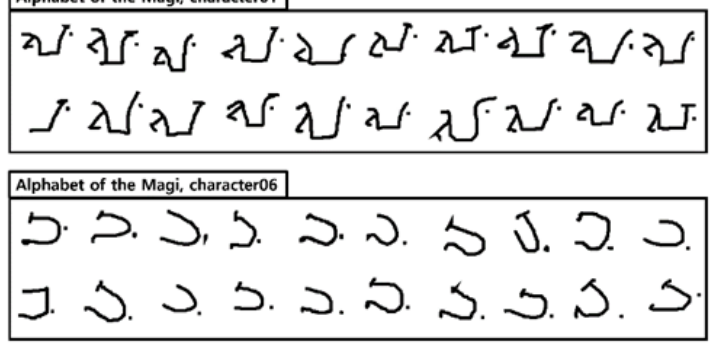
Figure 3. Character variation samples of Omniglot data.